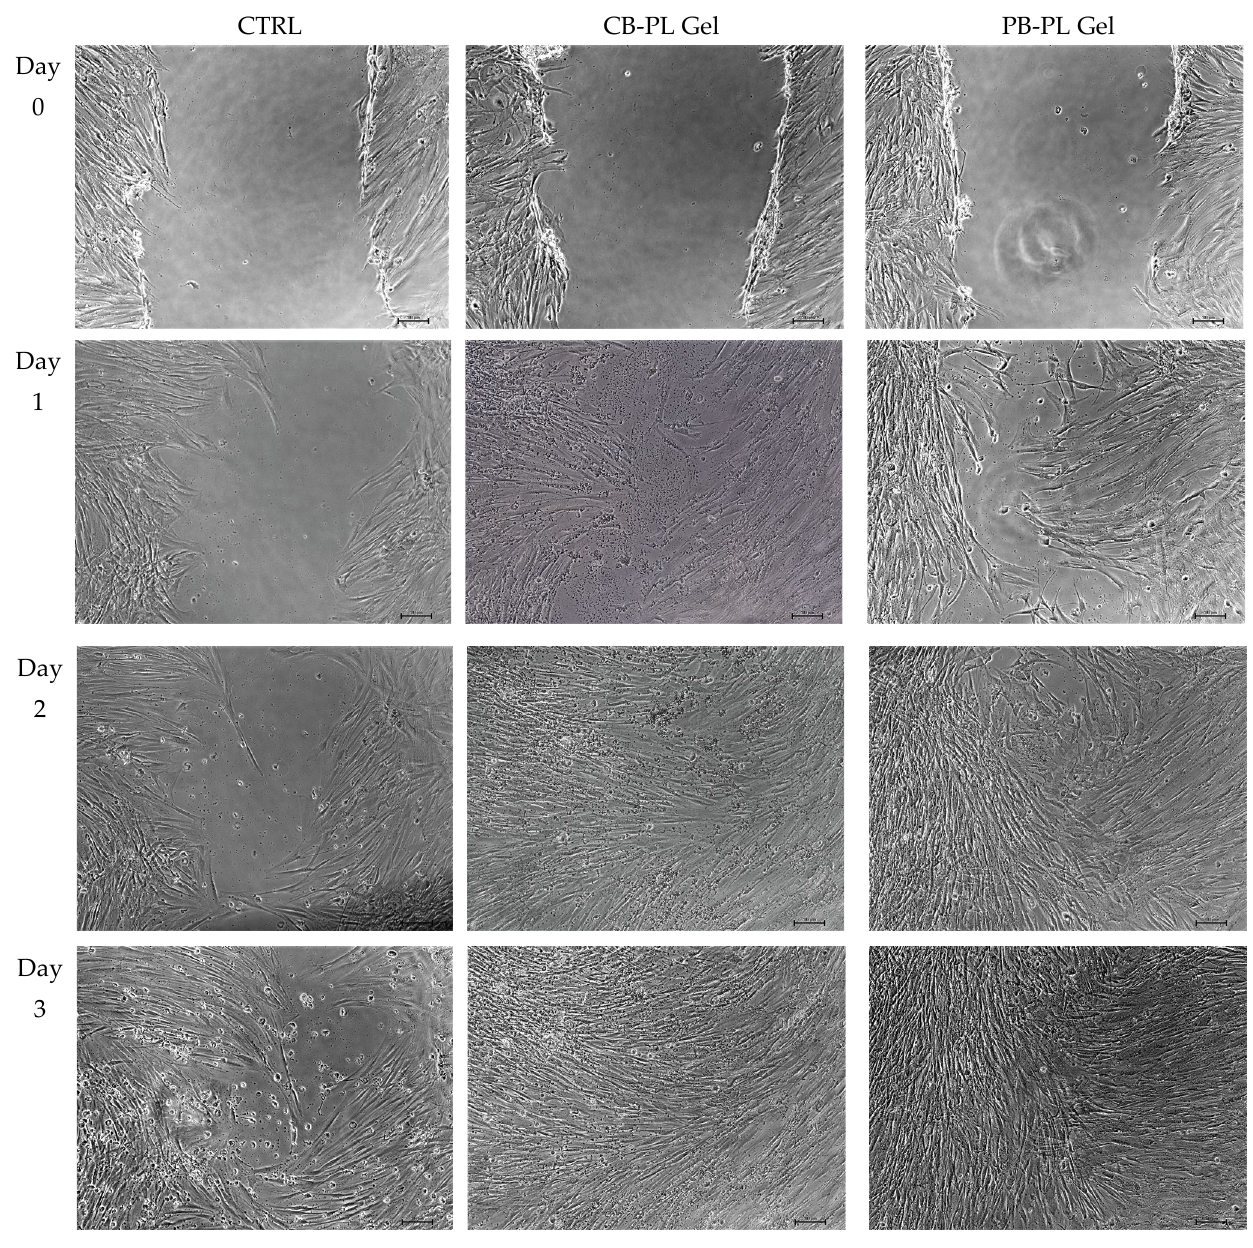
Figure 3. The cell migration of HOMF under treatment of CB-PL gel, PB-PL gel, and CTRL was observed using phase contract micrographs at 100× magnification in the wound scratch assay on days 0, 1, 2, and 3. Both PL gels were found to expedite the wound closure compared to the CTRL.